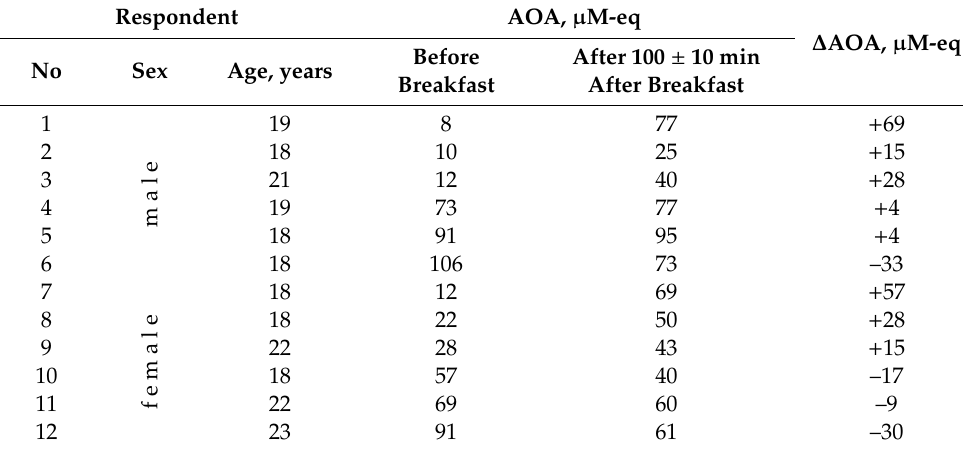
Table 4. This AOA of skin before (fasting period) and after breakfast (n = 1).